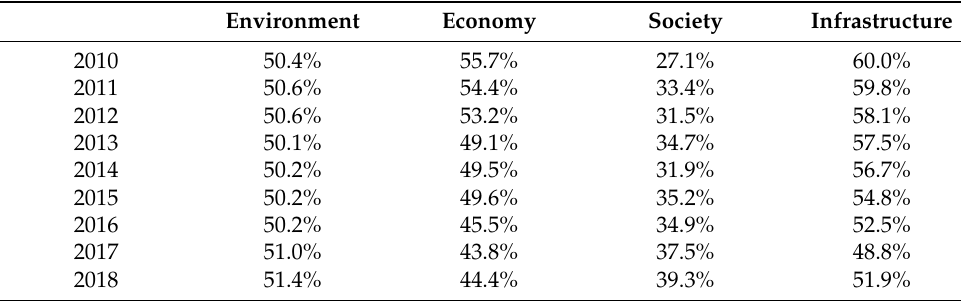
Figure 5. Changes in four dimensions of counties in Aba. ( a ). dimensional changes from 2012 to 2013; ( b ). dimensional changes from 2016 to 2017. Table 2. Variation of coefficient of disaster resilience in